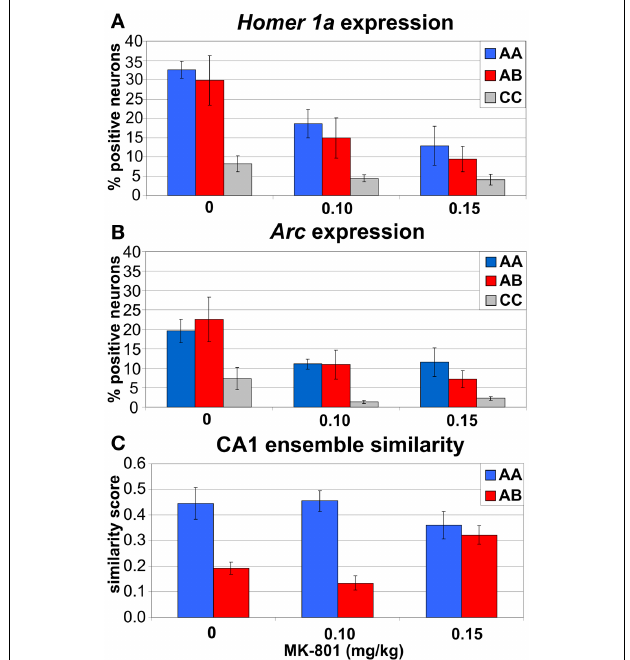
FIGURE 11 | Immediate-early gene imaging data summary . (A,B) both doses of MK-801 reduced expression of IEGs Homer1a (A) and Arc (B) in